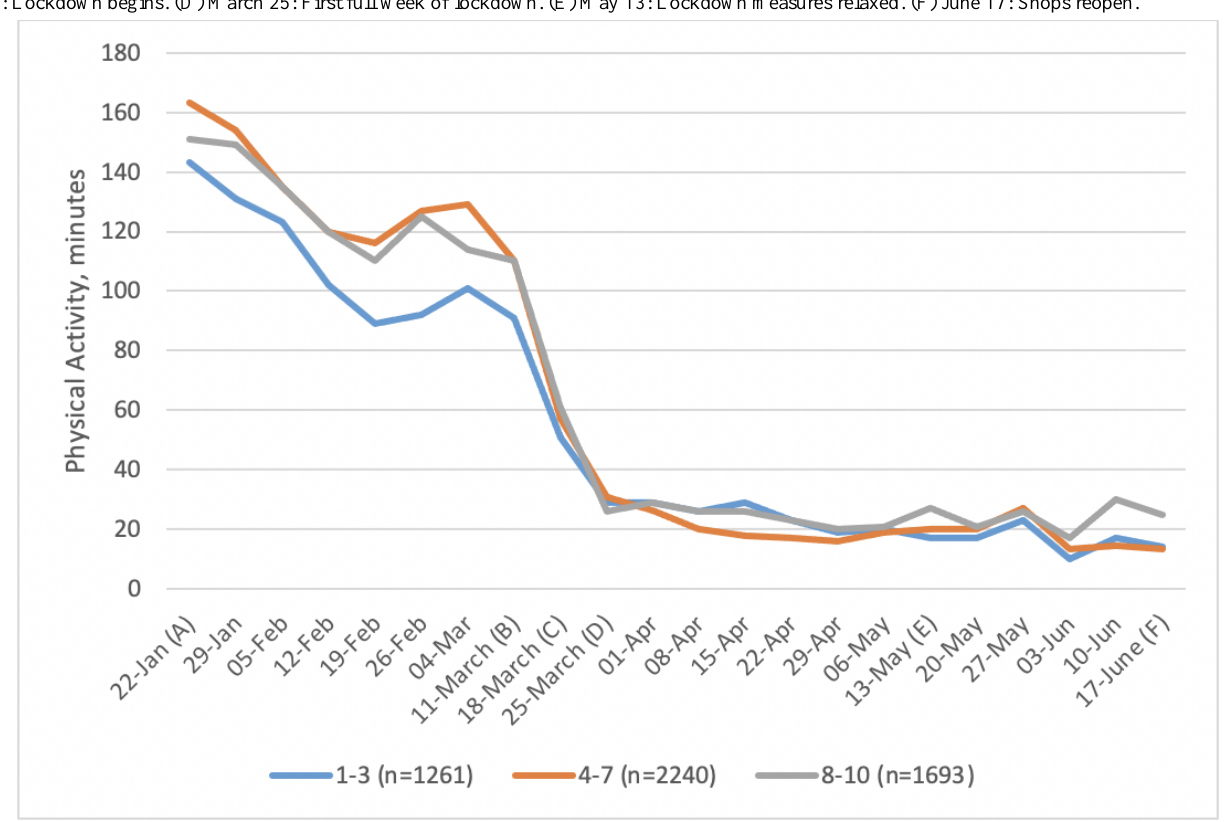
Figure 5. Weekly minutes (median) of activity by indices of multiple deprivation. Important dates are marked on the x-axis as follows. (A) January 22: Baseline, week before first COVID-19 case announced in the United Kingdom. (B) March 11: Social distancing measures introduced. (C) March 18: Lockdown begins. (D) March 25: First full week of lockdown. (E) May 13: Lockdown measures relaxed. (F) June 17: Shops reopen.